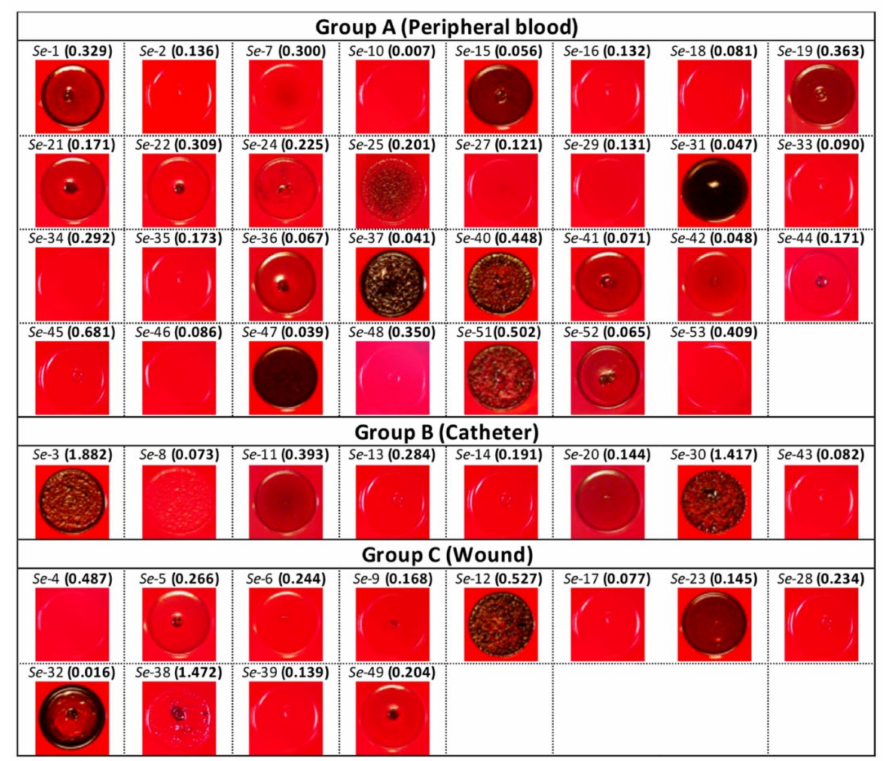
Figure 4. Relationships between the PIA expression and biofilm formation among the S. epidermidis clinical isolates. Qualitative detection of the slime formation on the Congo Red agar (CRA) plates of the S. epidermidis clinical strains grown at 37 ◦ C subdivided according to their isolation source. The name of each clinical strain and, in brackets, its AI value obtained in BHI SUC , are reported above the